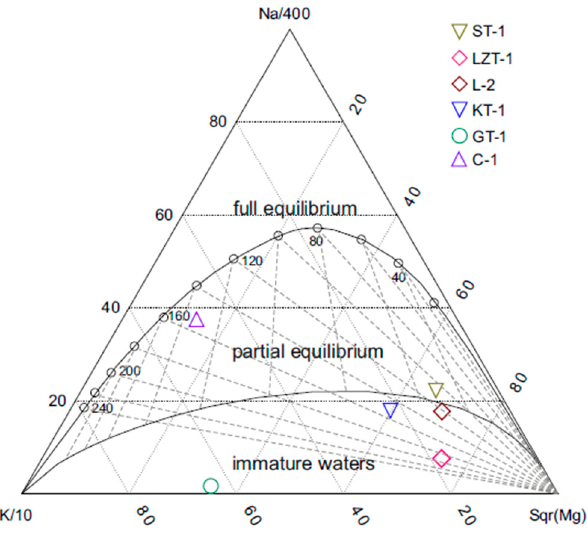
Figure 5. Analyzed waters on a modified triangular Na-K-Mg diagram (based on [59]).